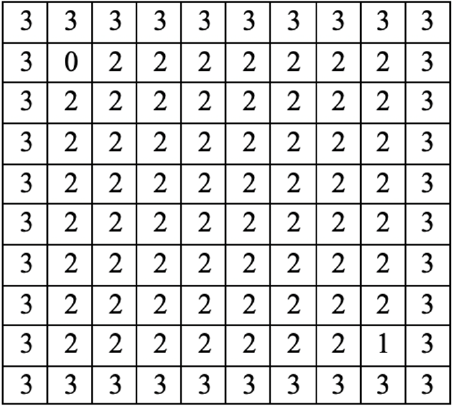
Figure 1. Single-chromosome data example.